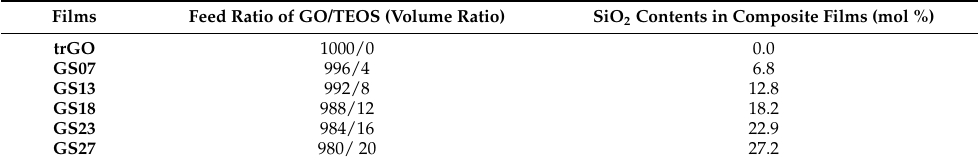
Figure 15. Transmission spectra of trGO films on slide glasses prepared with GO solutions of 5 mg mL − 1 (red) and 15 mg mL − 1 (blue). The dotted line denotes the transmission spectrum of the slide glass itself.